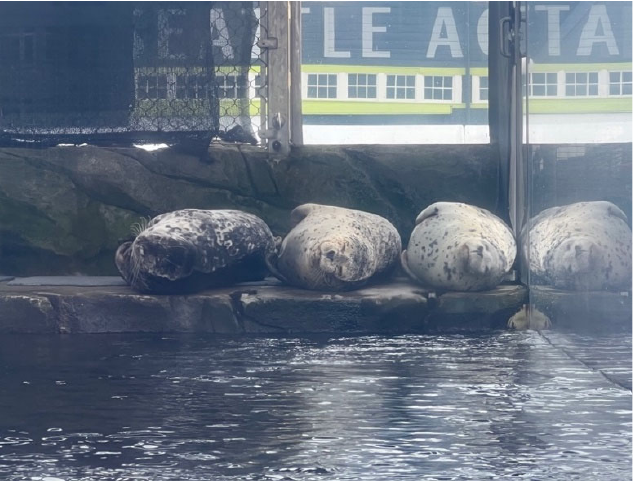
Figure 2. Three harbor seals engaged in Land Resting (from left to right: Hogan, Casey, and Barney). The Harbor seal exhibit was located outside and overlooked Elliott Bay (see Figure